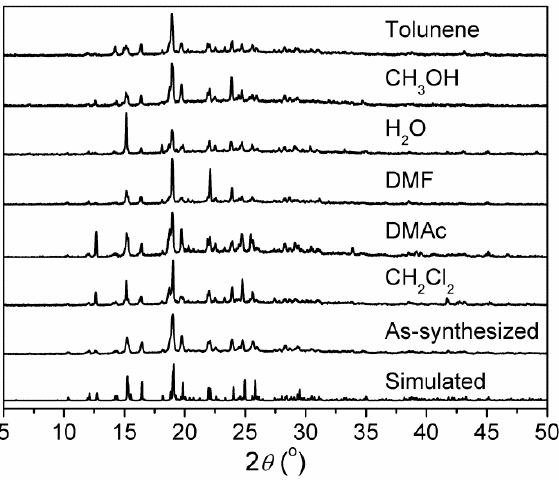
Figure 2. Simulated XRPD pattern of 1 and XRPD patterns of as-synthesized 1 and 1 immersed in different solvents for 24